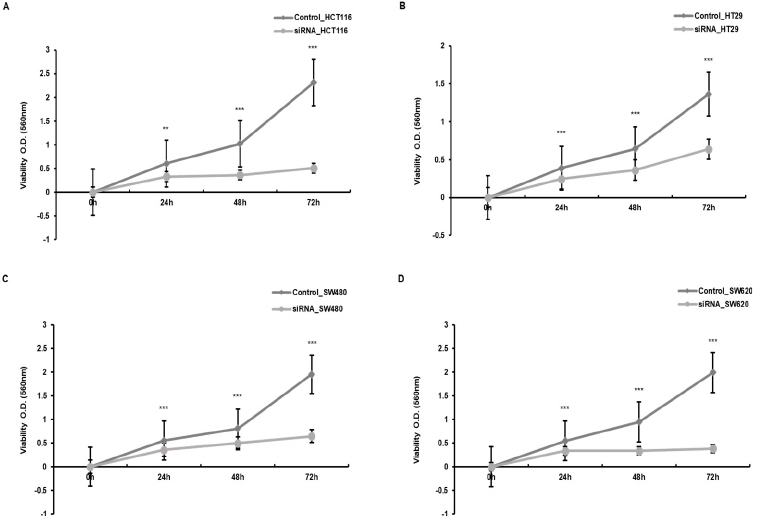
Figure 2. The comparison of the cell proliferation rate between control cells and siRNA-transfected cells in the CRC cell lines. ( A ) HCT116, ( B ) HT29, ( C ) SW480, and ( D ) SW620 (** p < 0.01, *** p < 0.001).